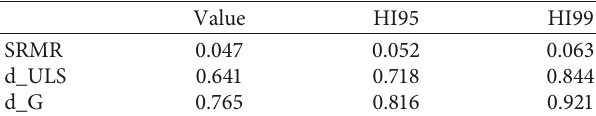
Table 2: Overall model fit.